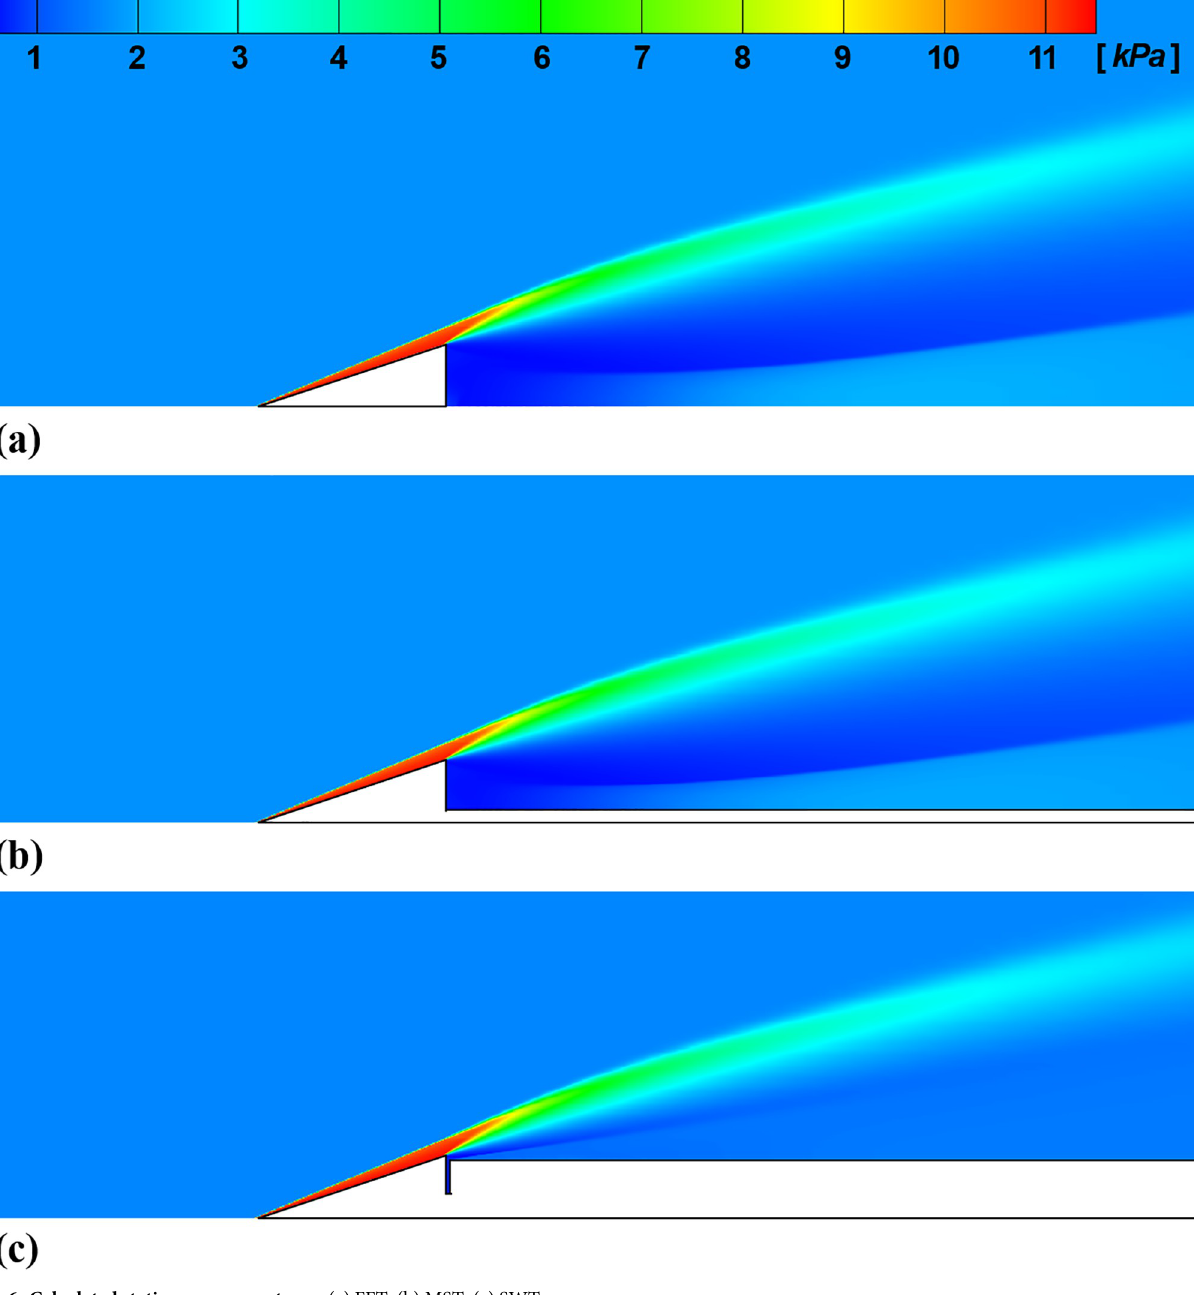
Fig 6. Calculated static pressure contours. (a) FFT, (b) MST, (c) SWT. pressure was relatively small within 5% because the pressure behind the shock wave in front of the test model, compared to the test model base pressure, is very high for the considered hyper- sonic flow condition. Because of the expansion fans near the test model base, the oblique shock wave was distorted, and the curvature of the shock wave was increased. The correspond- ing drag coefficient C of each technique was 0.283, 0.281, and 0.271 respectively. The details D